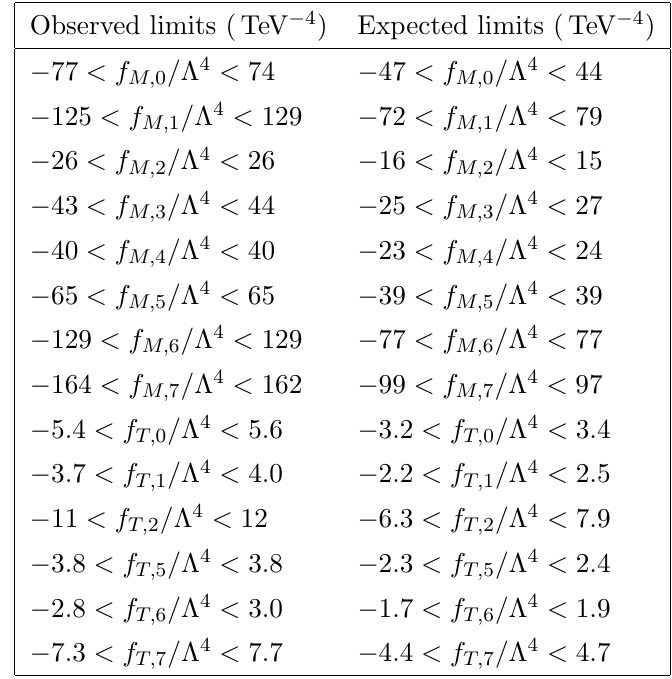
Table 4 . Observed and expected shape-based exclusion limits for the aQGC parameters at 95% CL, without any form